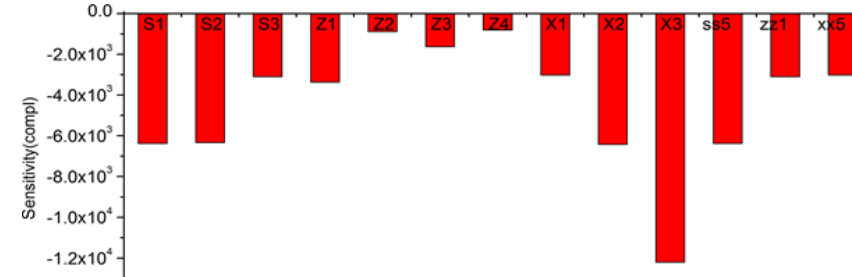
Figure 19. Sensitivity histogram of frame flexibility.